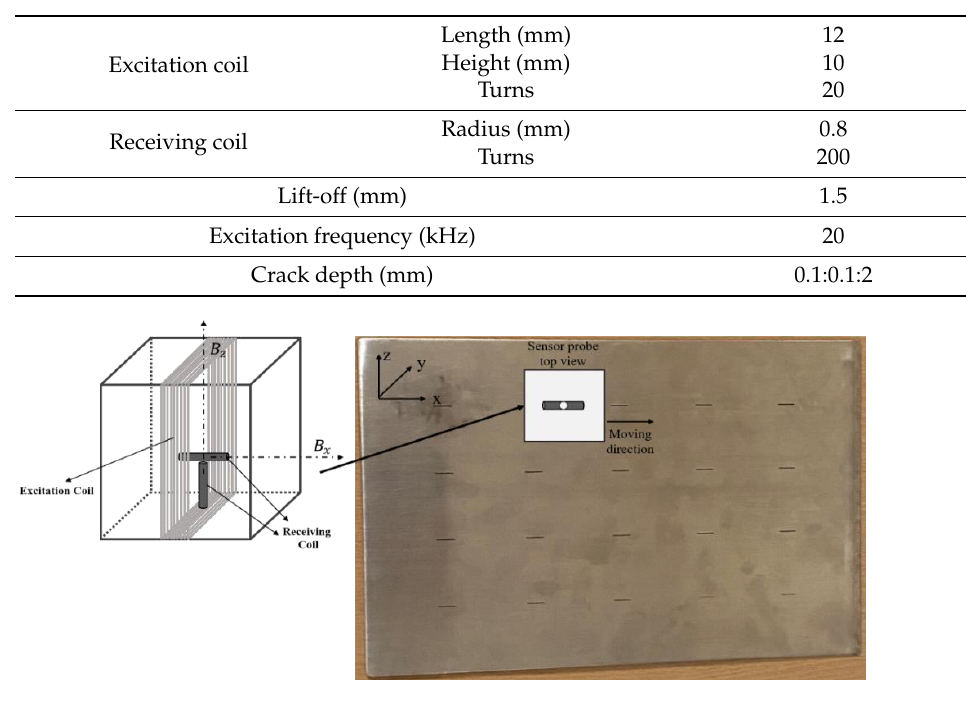
Figure 8. The trajectory of the sensor probe.